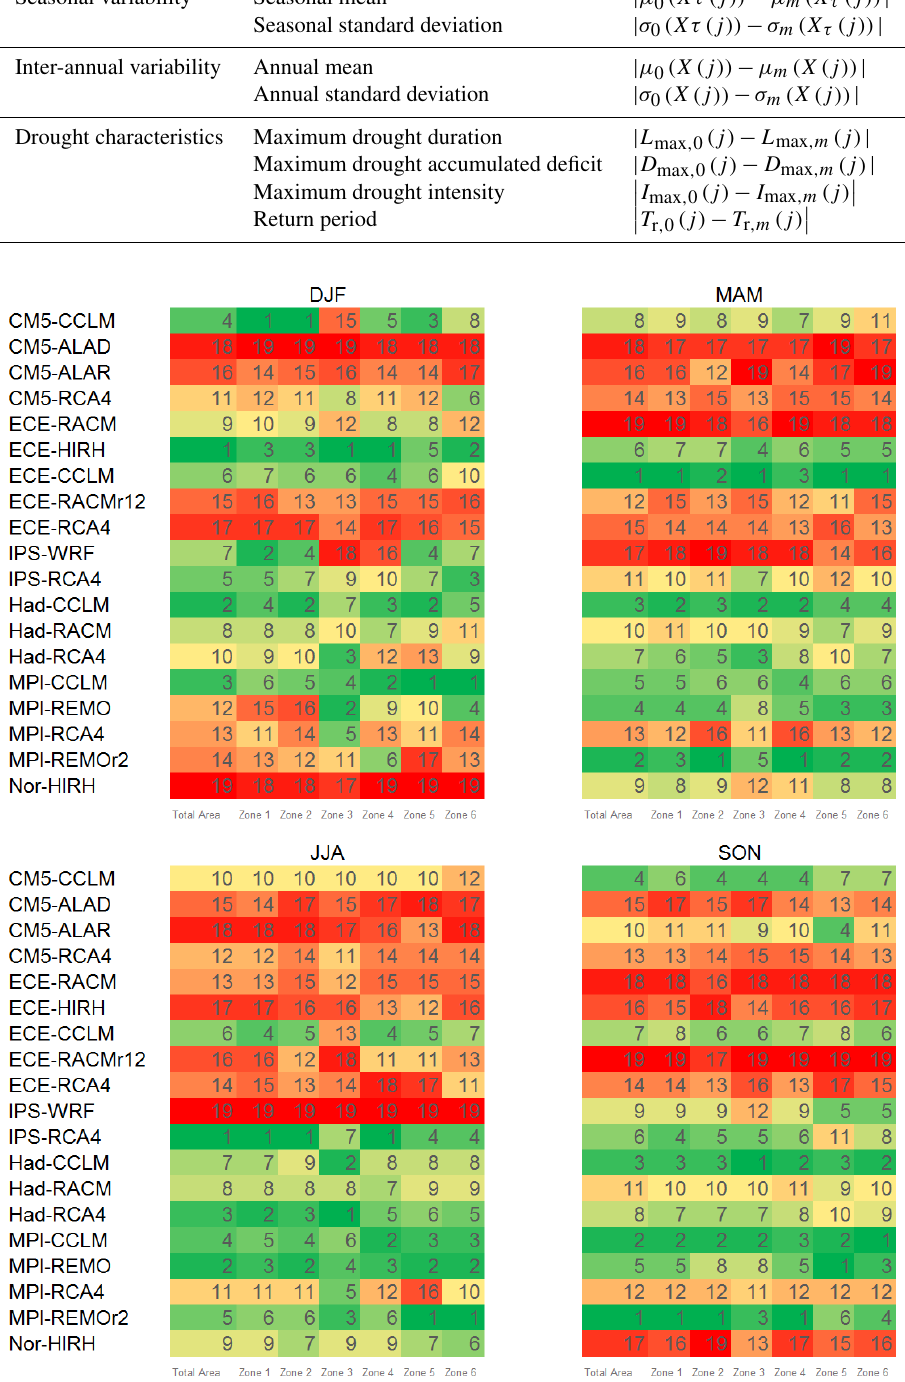
Figure 5. RCM ranking with respect to seasonal variability of mean temperature for the entire area and the climatically homogenous